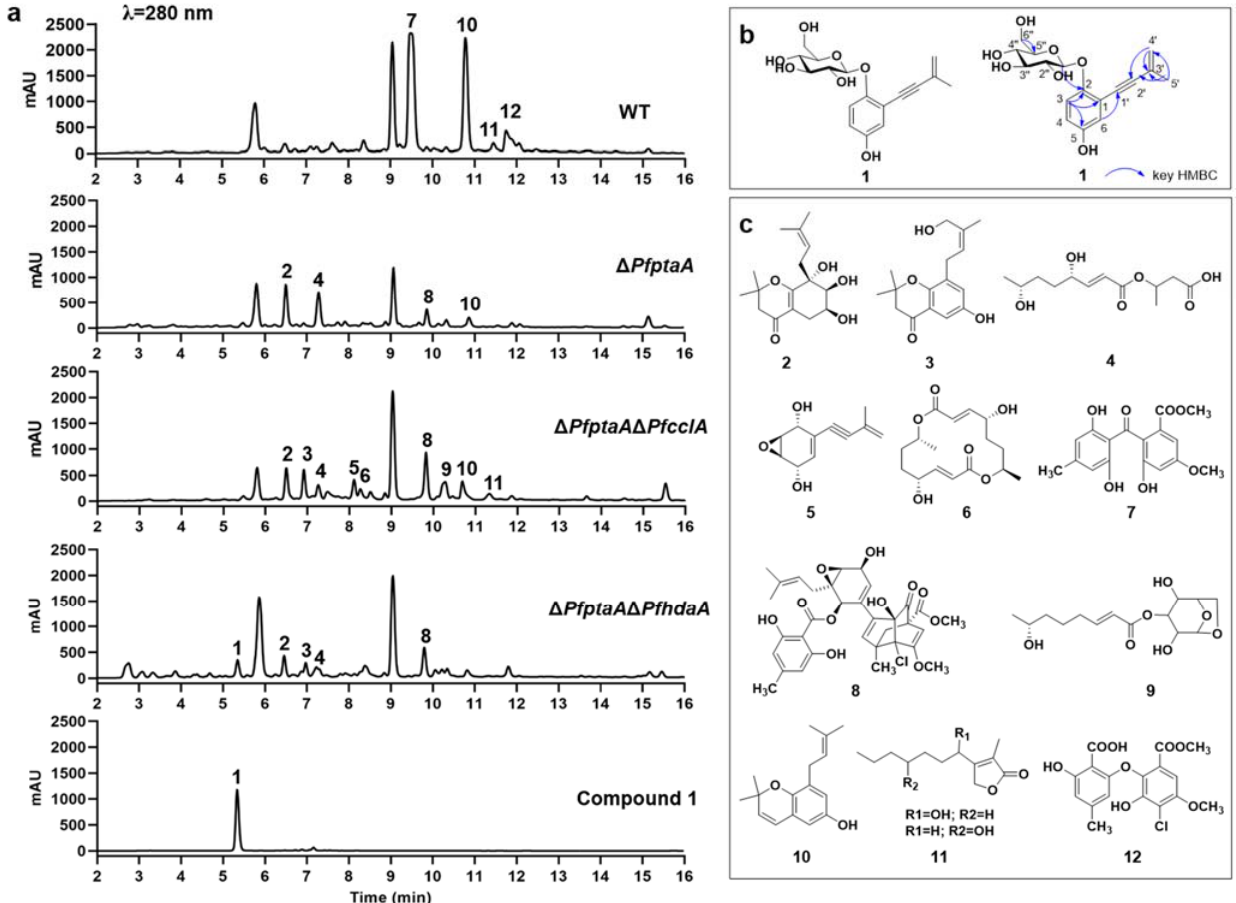
Figure 2. Secondary metabolites analysis for P . fici wild type and mutants. ( a ) HPLC analysis of secondary metabolites; ( b ) structure and key HMBC correlation of pestaloficiol X ( 1 ); ( c ) known SMs produced by P. fici strains in this study.